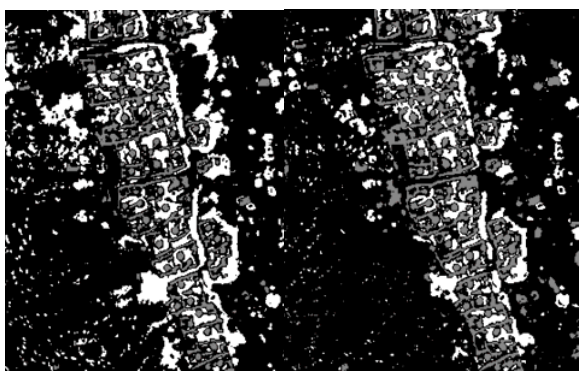
Fig. 6 Change detection by PCA (left) and delta cue